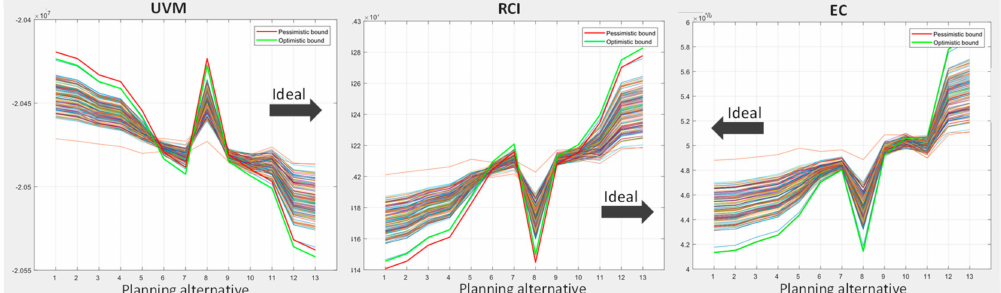
Figure 7. Results of the Monte Carlo simulation for each planning alternative. Simulation results exceeding pessimistic or optimistic bounds bear, respectively, risks or opportunities. The order of the planning alternatives in the horizontal axis indicates lower to higher UVM performance.